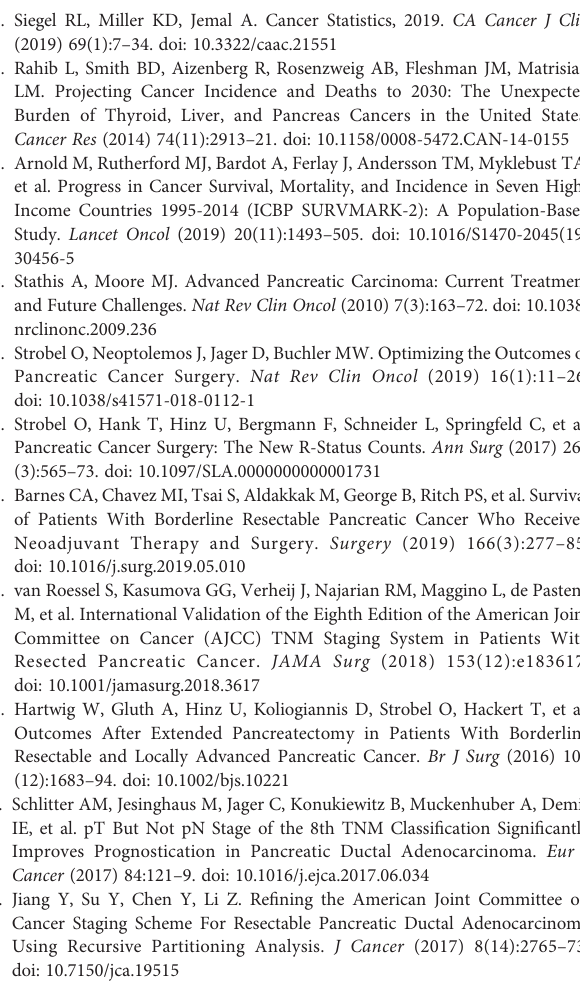
Supplementary Figure 1 | Kaplan – Meier Curve Analysis. Survival curves strati fi ed by different TJC types. [ (A) Tongji cohort; (B) Taiwan cohort]. Patients with TJC Types I and II were better than those with TJC Type III/IV. Supplementary Figure 2 | X-tile analysis of the risk score in the training cohort. Supplementary Figure 3 | Kaplan – Meier curve analysis. Survival curves strati fi ed by risk groups in patientsat AJCC stages I, II, and IIIin the training cohort (A – C) and the validation cohort (D – F)